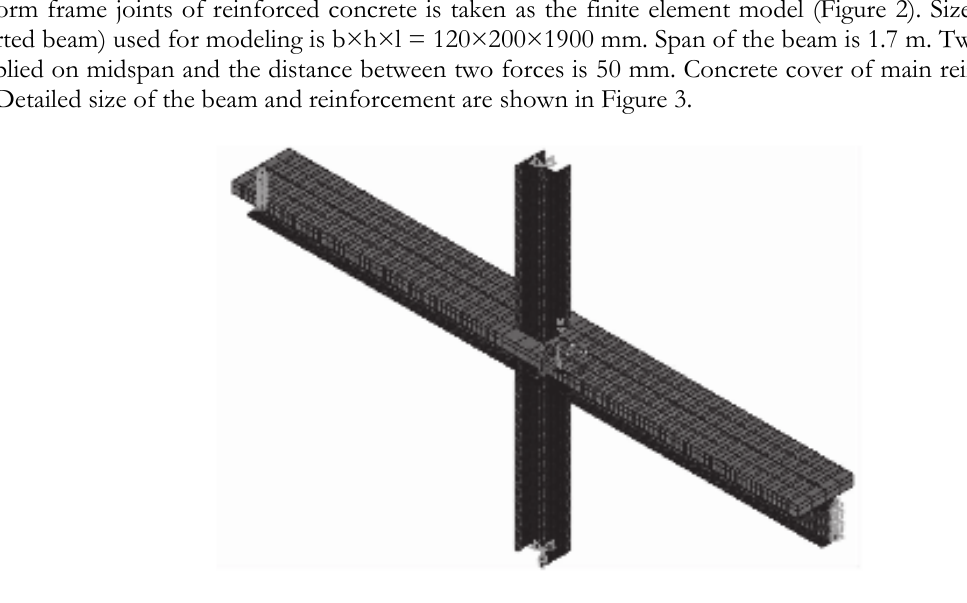
Figure 2: Frame joint